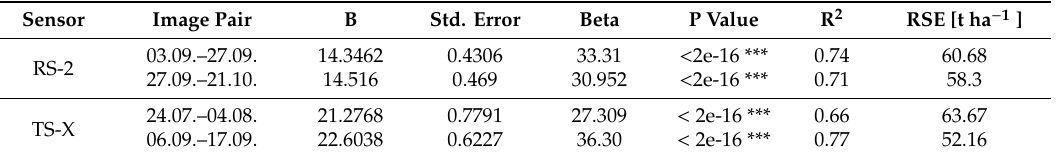
Table 5. Overview of the model statistics, adjusted R² and Residual Standard Error (RSE) for the linear regression AGB model based on canopy height.